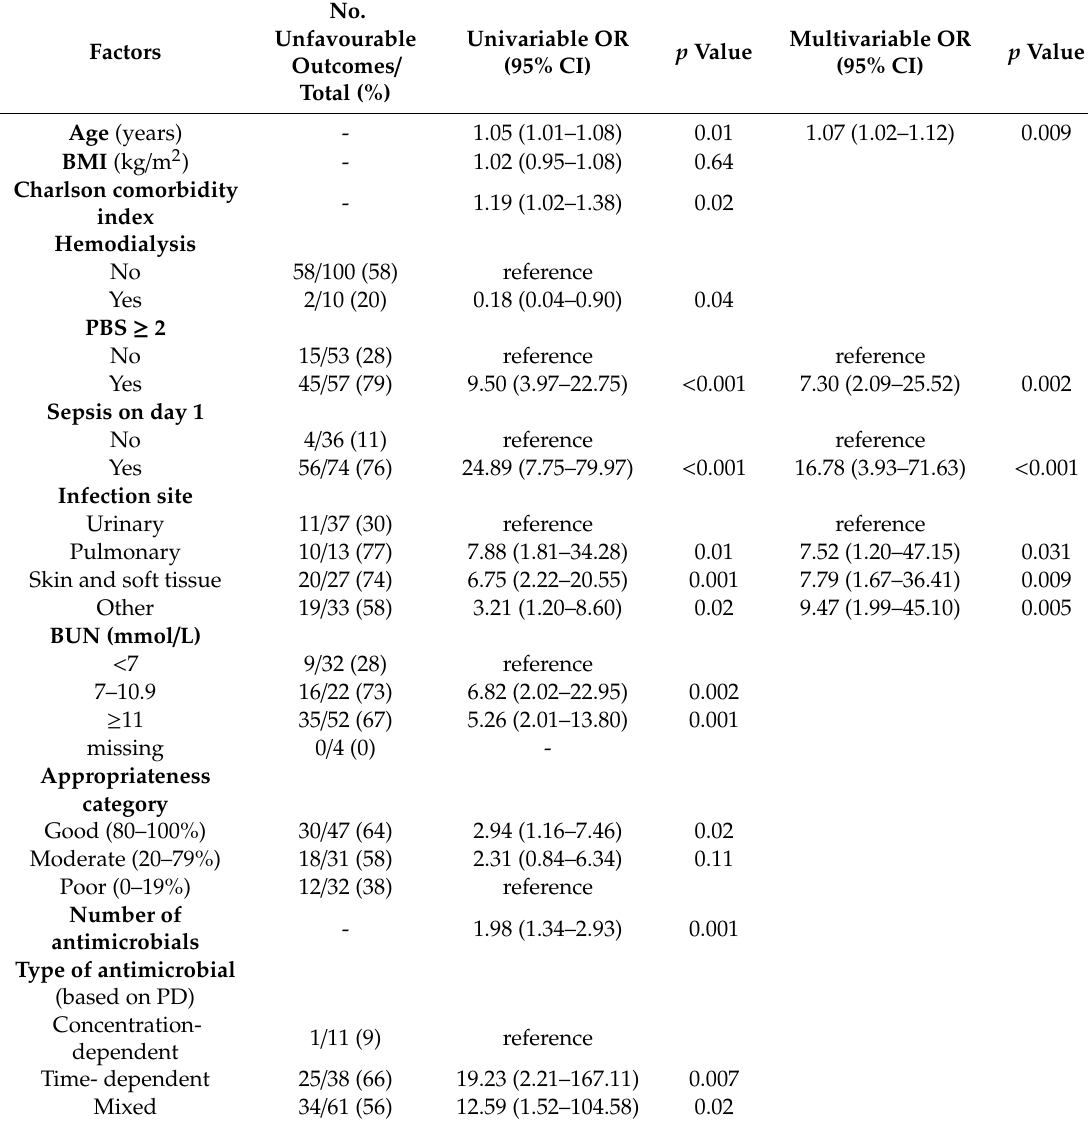
Table 5. Factors associated with unfavourable